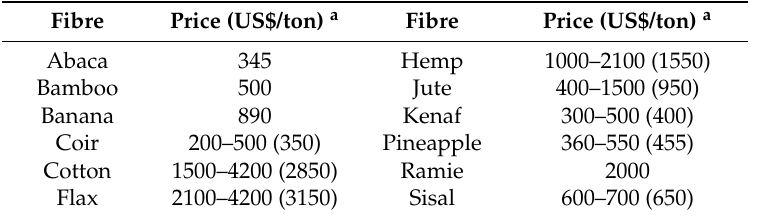
Table 7. Price per tonne of some natural fibres. Adapted from: [66,80,88]. a Mean value between